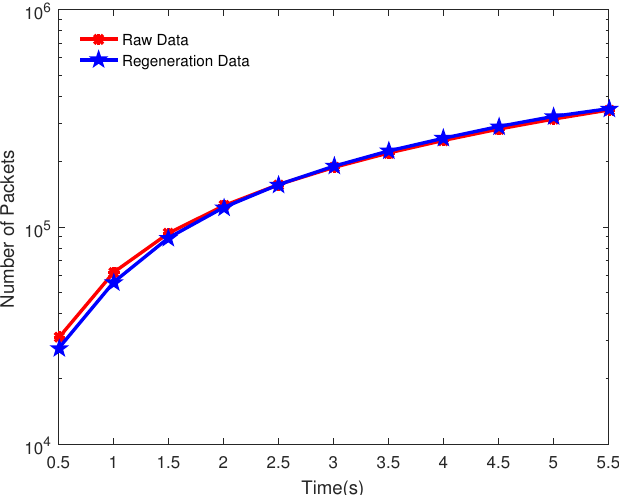
Figure 9. Comparison Chart of The Total Sum of Packets Sent on The Time Series.